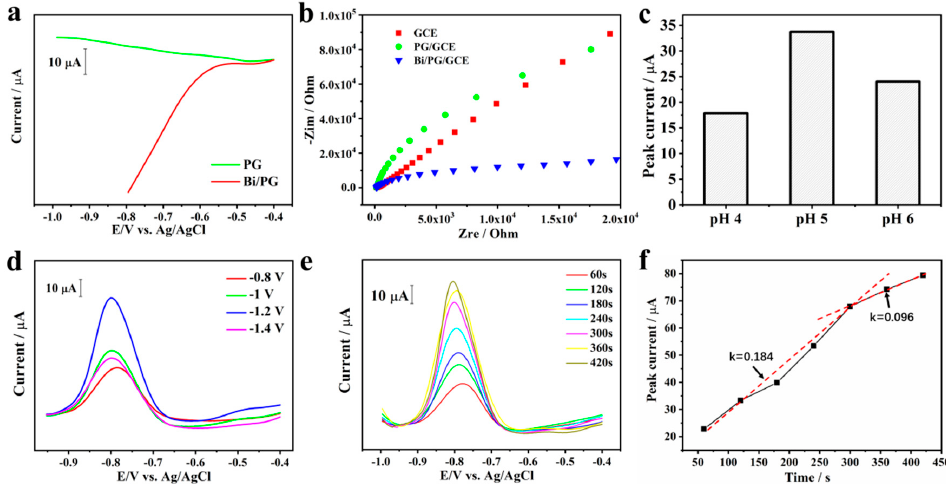
Figure 2. ( a ) SWASV of PG and Bi@PG in 0.2 M (pH 5.0) acetic acid bu ff er solution; ( b ) Nyquist plots of GCE, PG / GCE, and Bi@PG / GCE in 0.1 M NaCl solution; ( c ) e ff ect of pH values on the peak current responses; ( d ) SWASV of Bi@PG in 10 − 9 M Cd 2 + / 0.2 M (pH5.0) acetic acid bu ff er solution